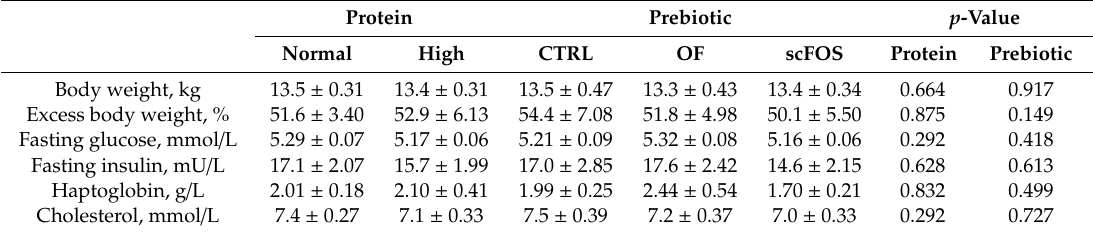
Table 2. Averaged e ff ects of protein level and prebiotic supplementation on feces characteristics and fecal concentrations of fermentation